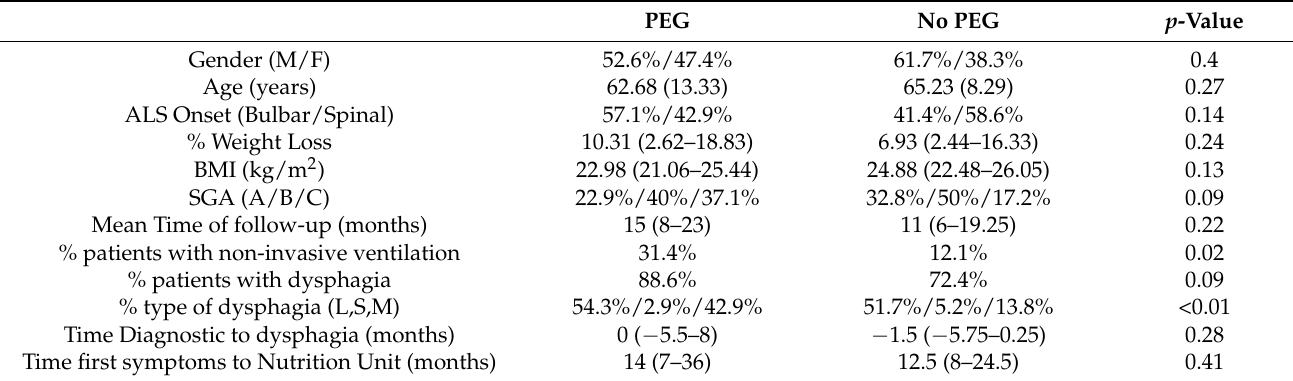
Table 1. Differences in variables between those who had percutaneous endoscopic gastrostomy (PEG) implanted and those who did not. M, male; F, female; ALS, amyotrophic lateral sclerosis; BMI, body mass index; SGA, subjective